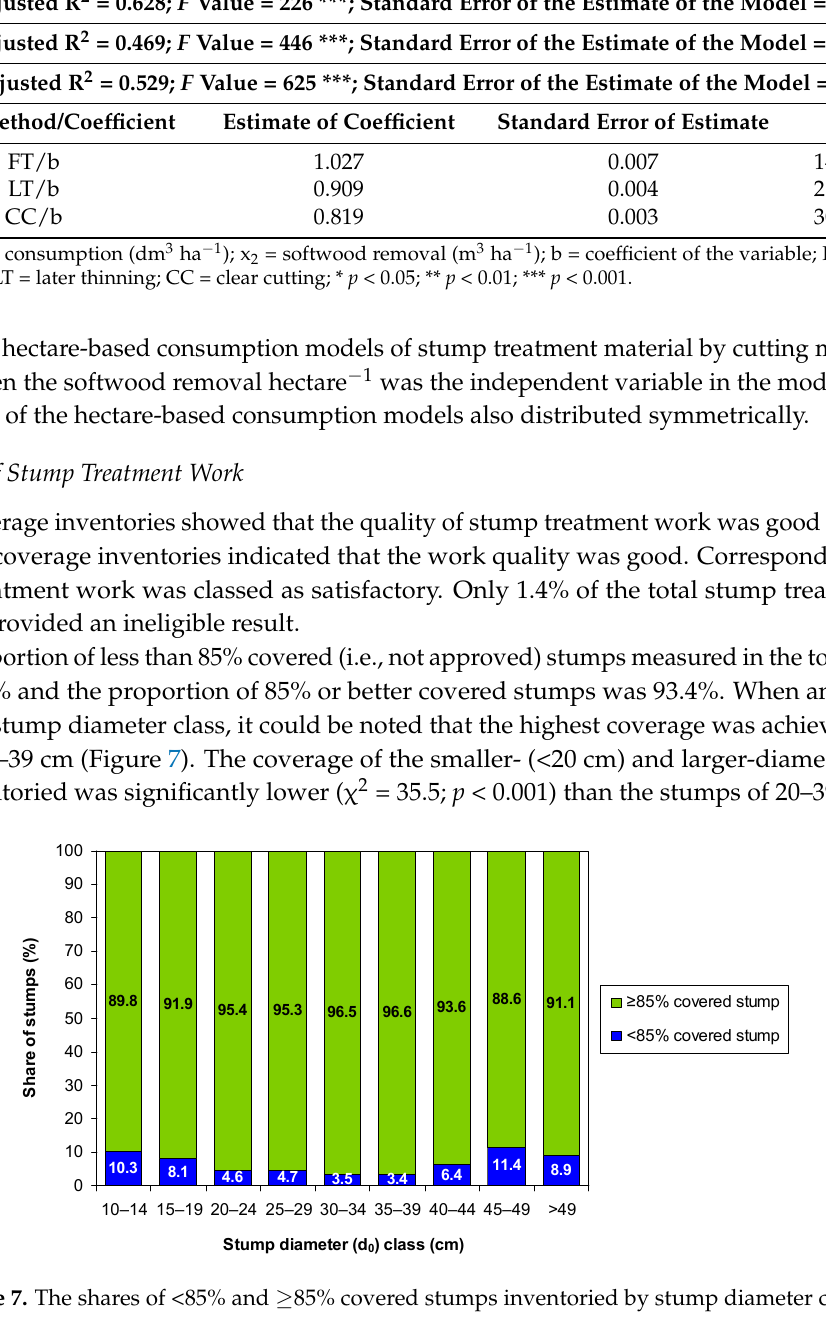
Table 5. The average coverage rates by stump diameter class in the study.